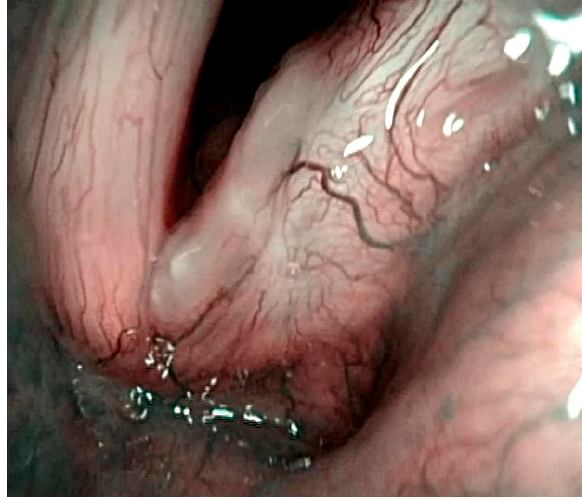
Figure 8. Histologically-verified low-grade dysplasia presenting as leukoplakia of the left vocal cord. Ni classification of laryngeal leukoplakia—type I.